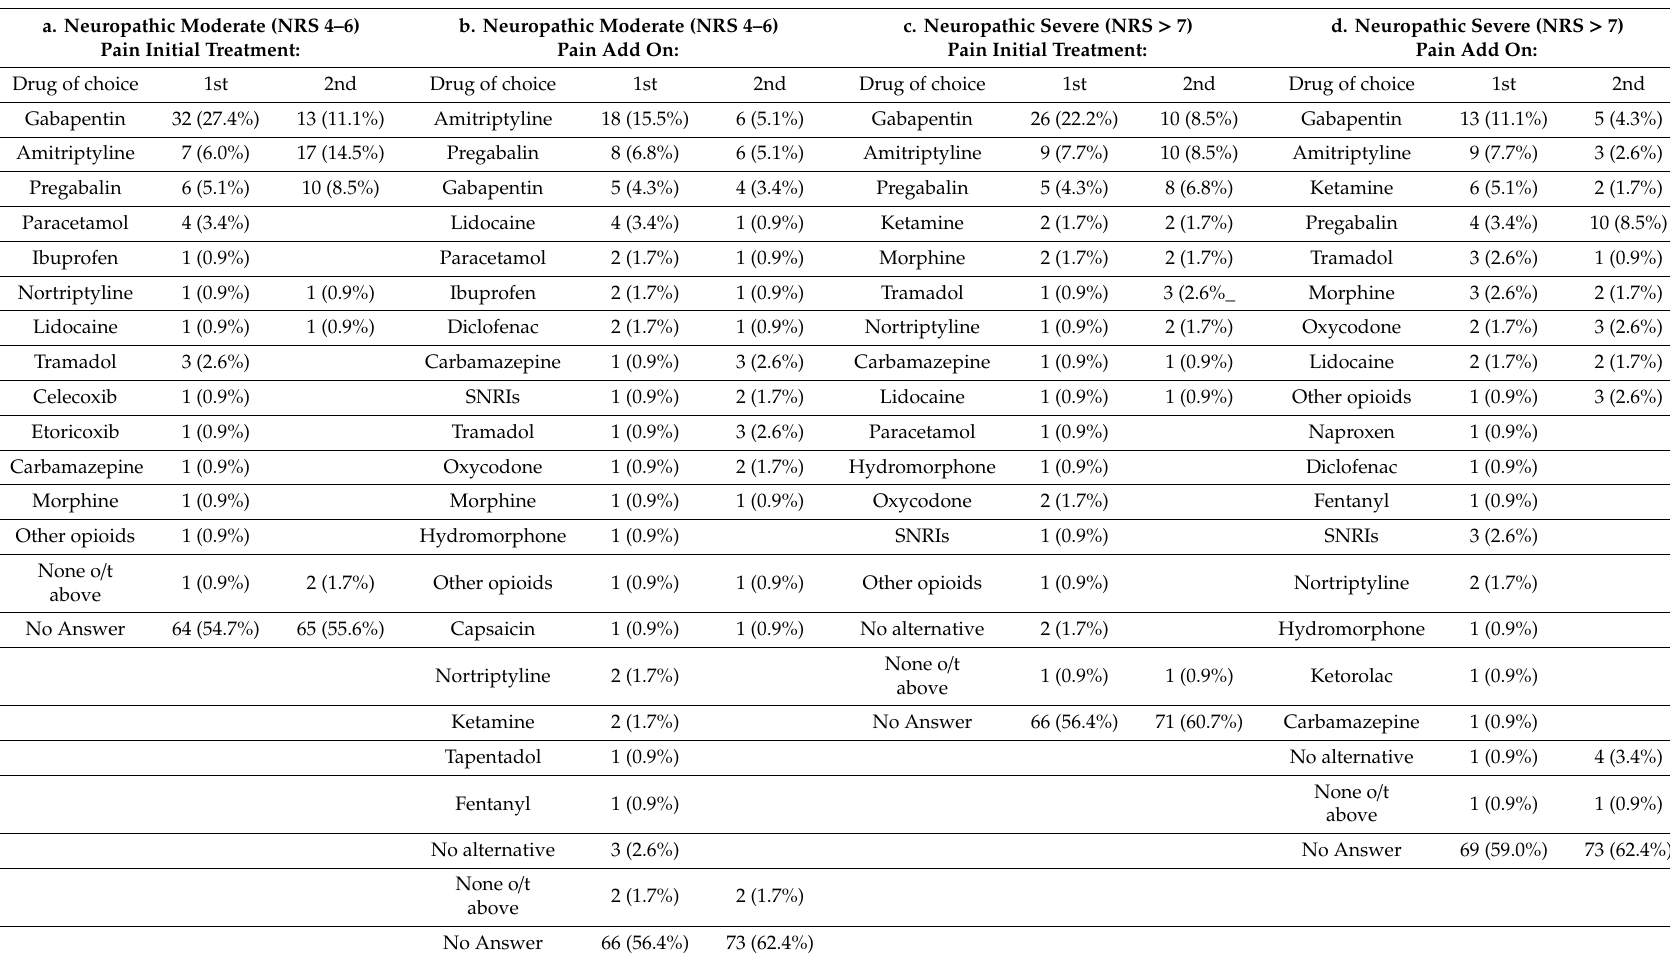
Table 5. Prevalence of first (and second) medication of choice and medication used as an add-on in case of moderate and severe neuropathic